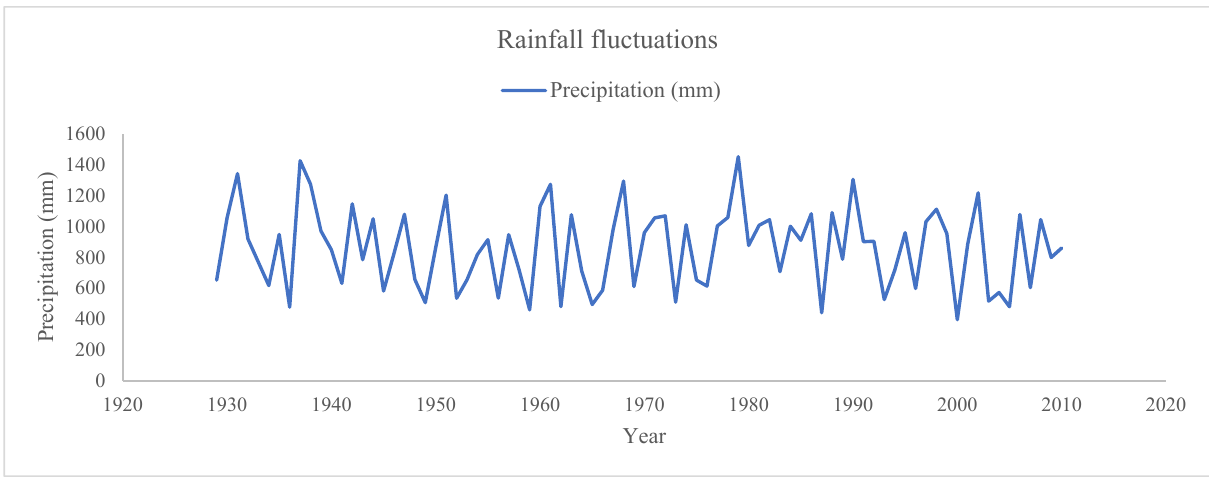
Figure A1. Changes in annual precipitation (mm) measured at Moshi Airport Moshi Municipal, Kilimanjaro station